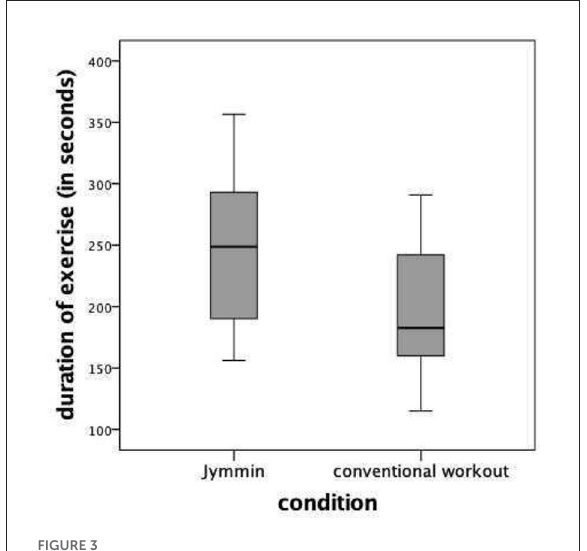
FIGURE3 Duration of the exercises during Jymmin and conventinal workout.